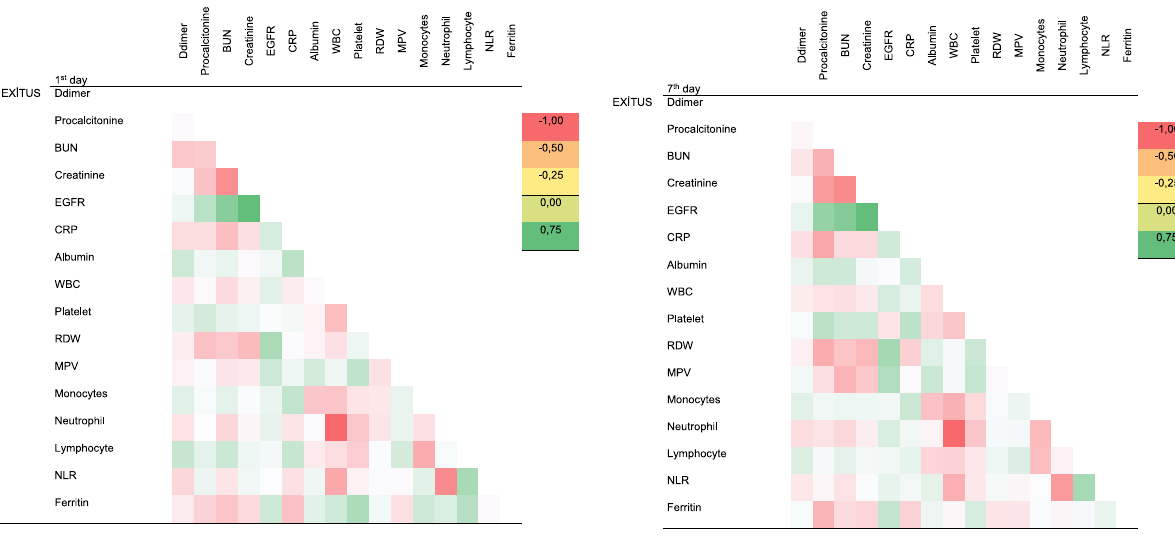
Table  : Correlation analysis of  th day variables of cases with mortality (Heat map correlation matrix between biochemical